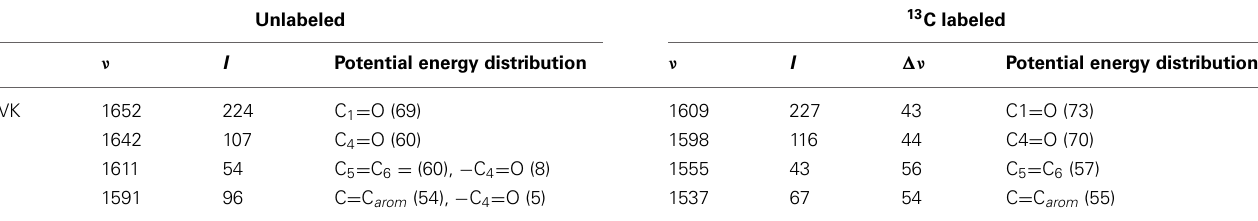
Table 3 | Normal mode frequencies (in cm − 1 ), intensities (in km/mol) and PEDs (in %) calculated using ONIOM methods for unlabeled and 13 C labeled neutral